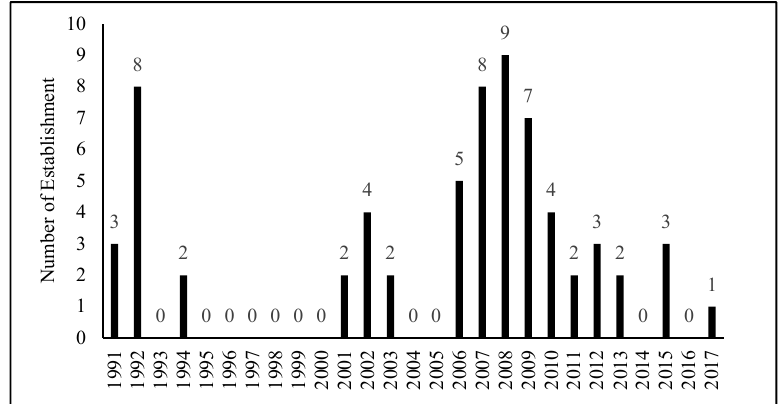
Figure 1. The establishment of development zones in Guangxi from 1991 to 2017.